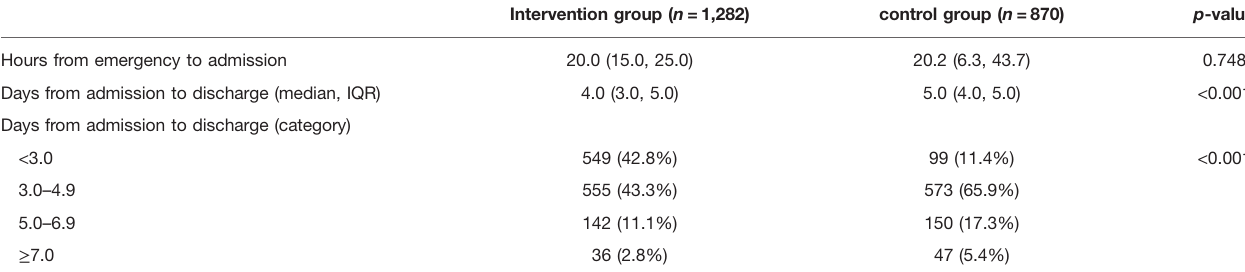
TABLE 2 | Comparison of time between the two